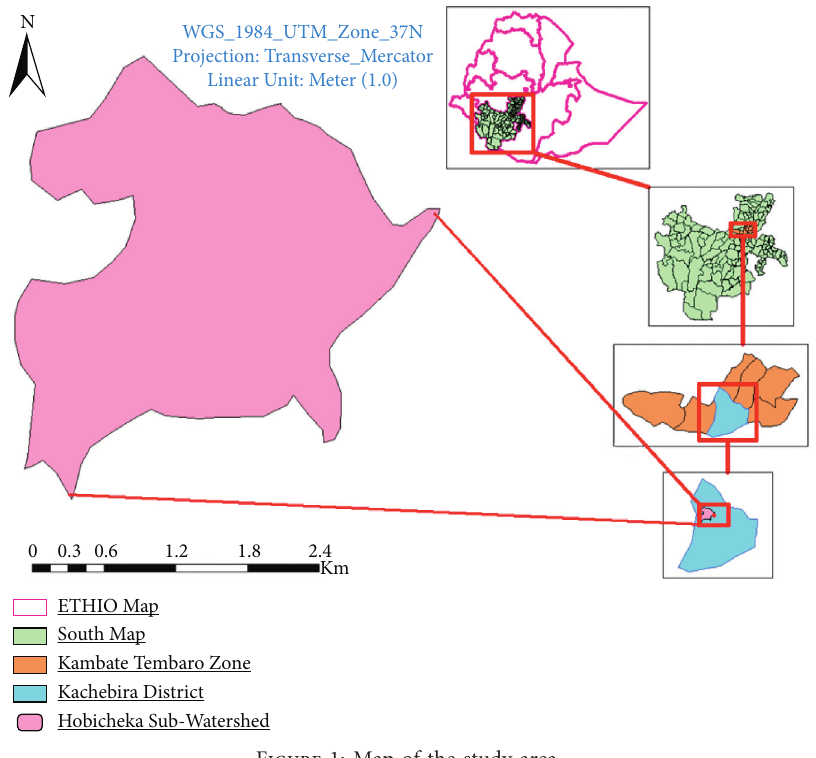
Figure 1: Map of the study